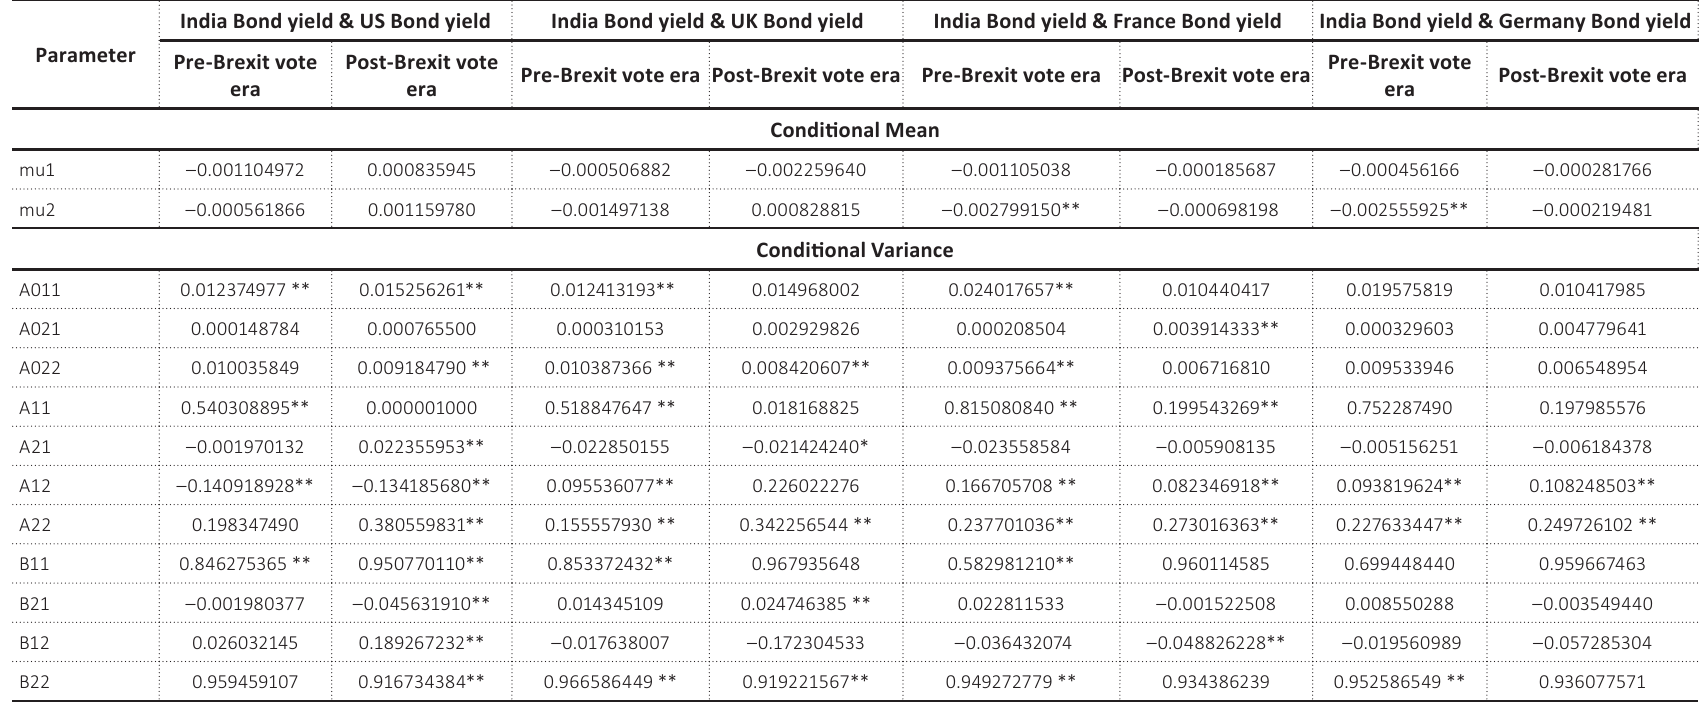
Table 5. Estimation of bivariate GARCH-BEKK model parameters